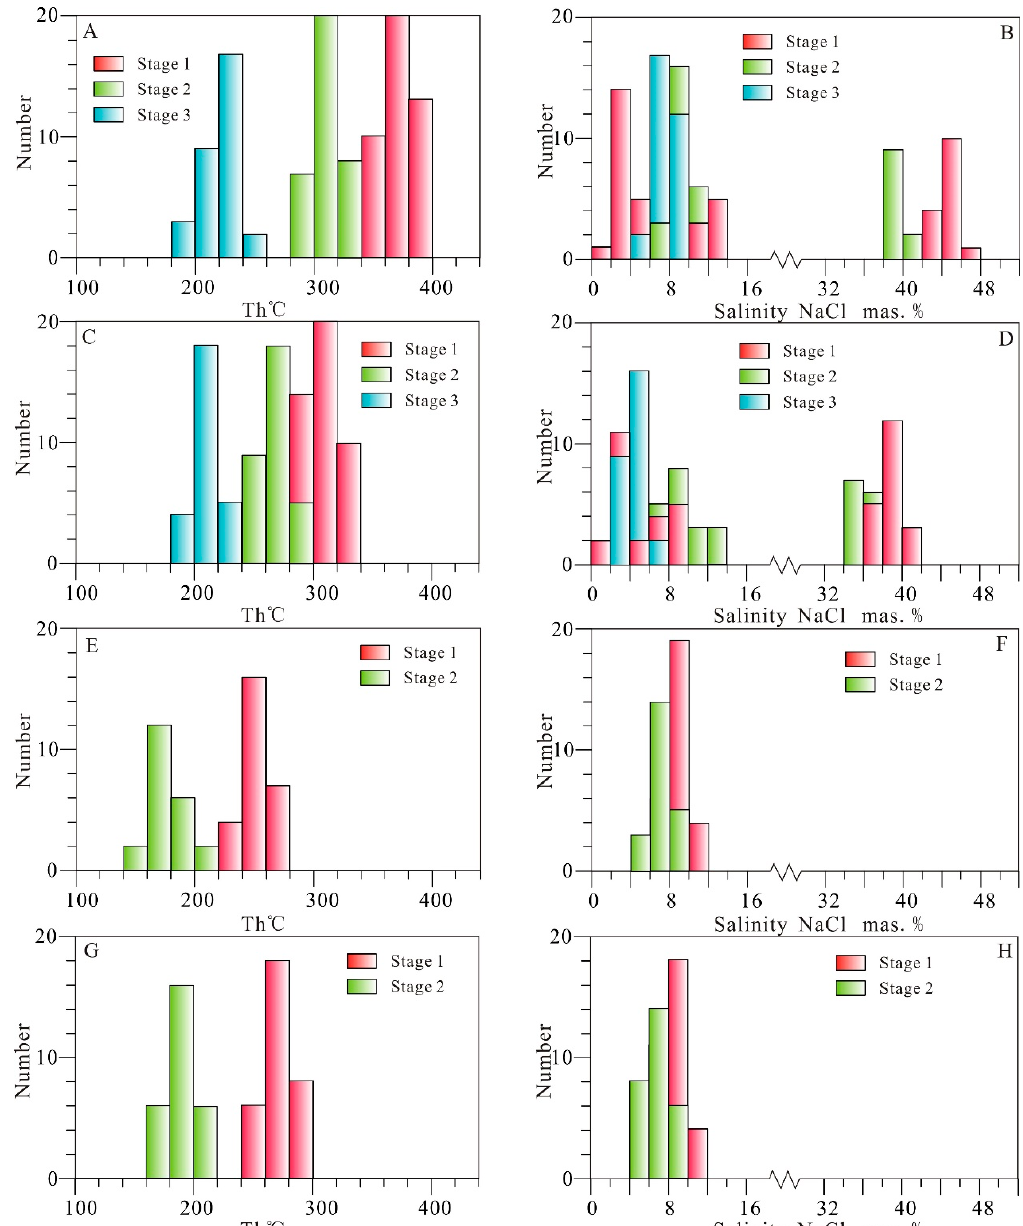
Figure 8. Histograms of microthermometric data for the FIs in the Qibaoshn polymetallic ore field. ( A , B ) Jinxiantou deposit; ( C , D ) Changgou deposit; ( E , F ) Hongshigang deposit; ( G , H ) Xingshanyu deposit.